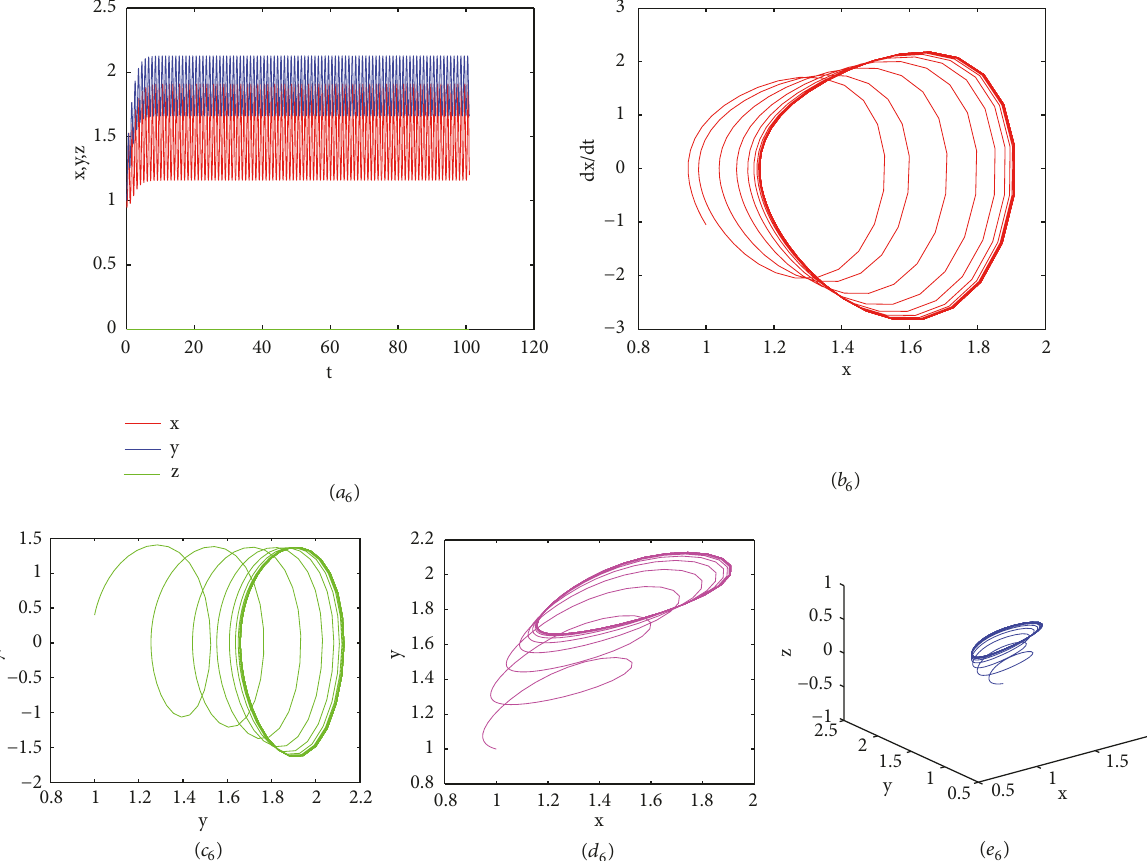
Figure 15: The results of Experiment 6: (𝑎 6 ) time series plot of 𝑥,𝑦, 𝑧 ; (𝑏 6 ) phase diagram of 𝑥 ; (𝑐 6 ) phase diagram of 𝑦 ; (𝑑 6 ) projected on the (𝑥,𝑦) -plane; (𝑒 ) on the three-dimensional 6